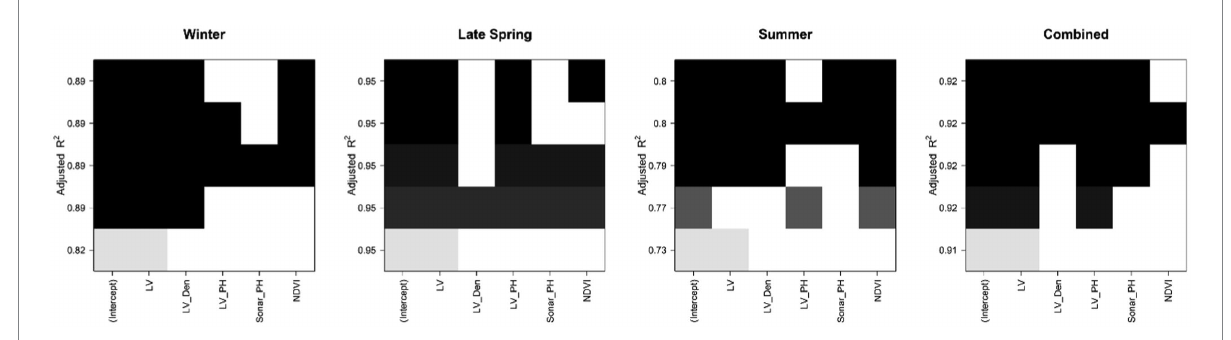
FIGURE 4 The color map of Adjusted R 2 values comparing the performance of models involving five senor-based predictors (from 1 to 5 predictors and an intercept variable per subset) and fresh biomass in each dataset at the plot level. Each predictor is presented by a colored square and arranged with other predictors of the same color. Color darkness is proportional to adjusted R 2 values, where black is highest.